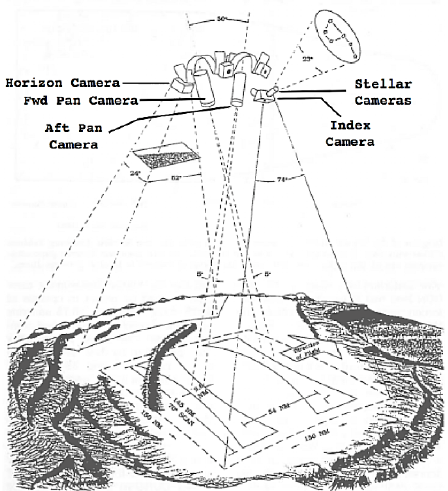
Figure 1: Corona KH-4B camera configuration and ground coverage (from Day,